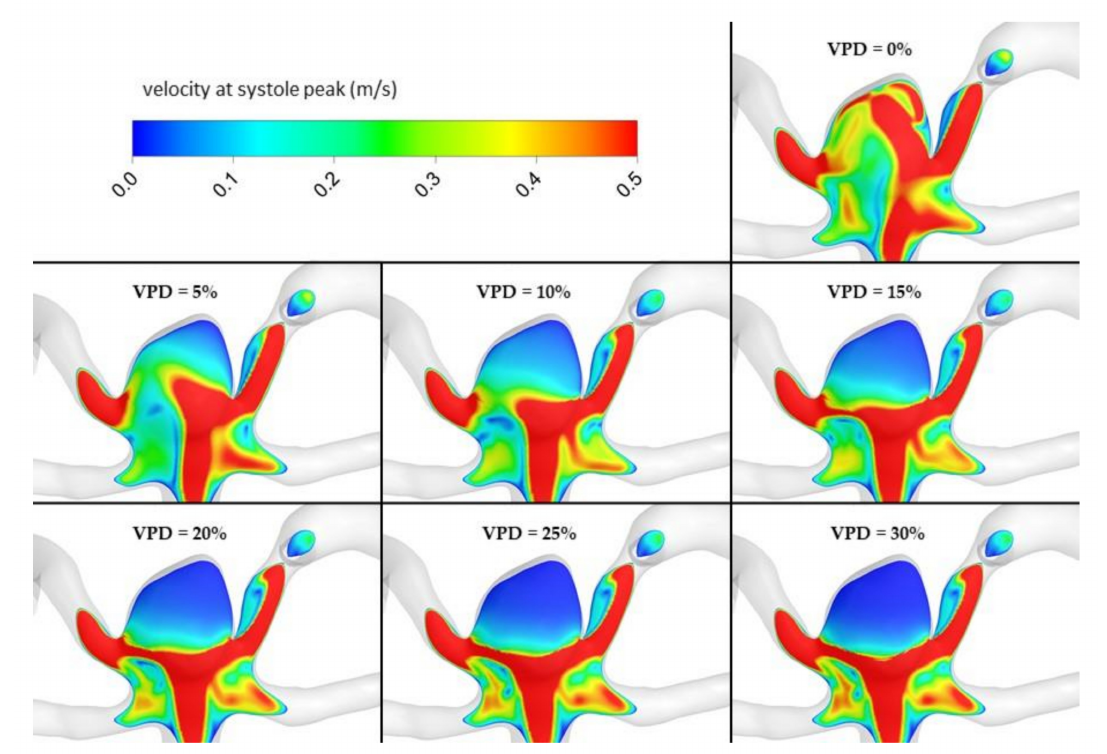
Figure 18. Velocity distribution at aneurysm cross section for selected VPD cases; transient simulations—systole peak.